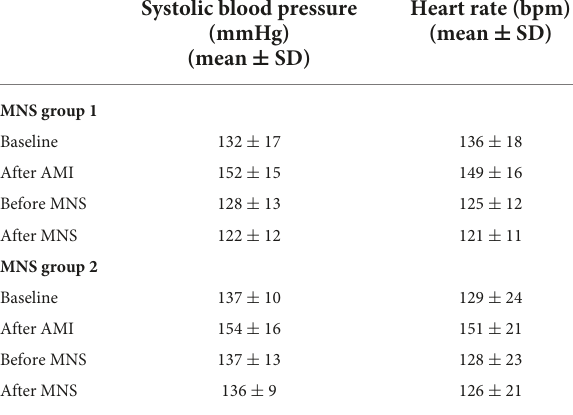
TABLE 1 Heart rate and blood pressure of experimental dogs in baseline, acute myocardial infarction (MI), and after 30 min of median nerve stimulation